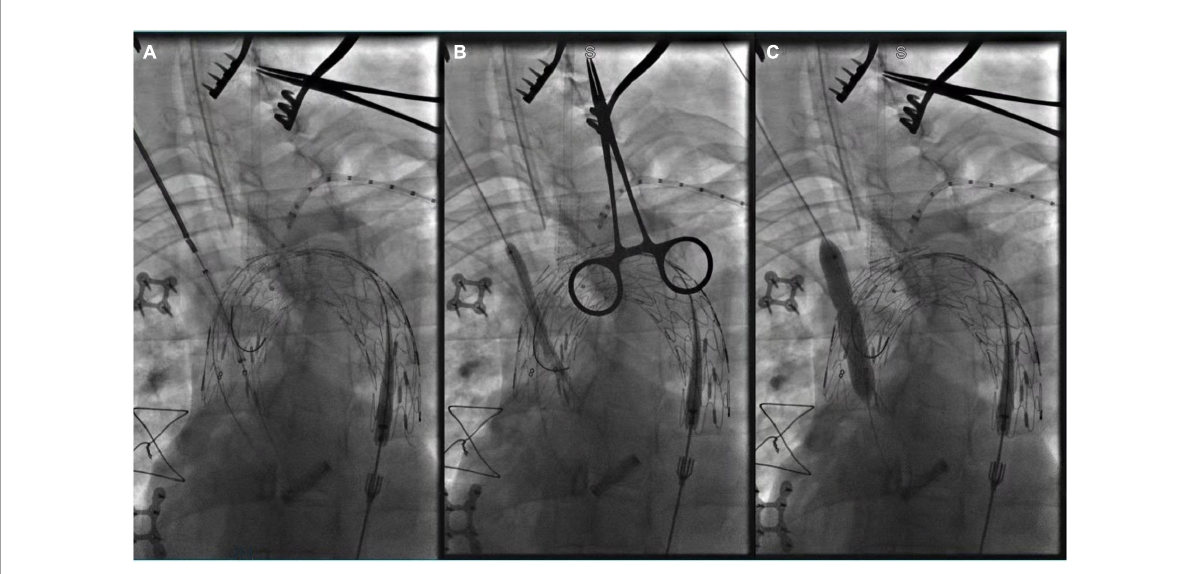
FIGURE3 Panel (A–C) showed in situ fenestration of the IA made by gradual balloon dilation (after the fabric part of the main stent-graft was punctured by using a hollow needle).